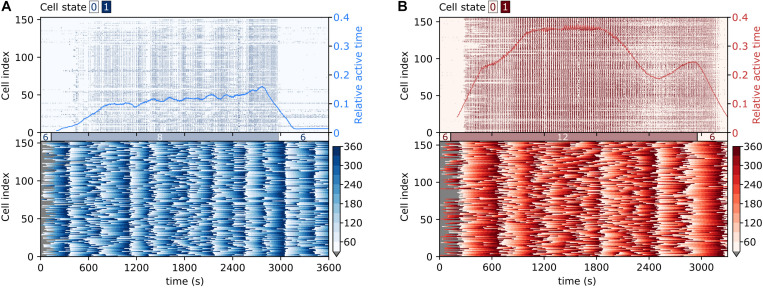
Visualization of collective fast and slow beta cell activity. Raster plots of binarized fast Ca2+ oscillations (upper row) and the corresponding color-coded phases of the slow oscillatory activity (lower row) in typical islets stimulated with 8 mM (A) and 12 mM (B) glucose. The blue and red lines superimposed on the raster plots denote the temporal evolution of the average relative active time, as specified by the scale on the right-hand side of the graph.